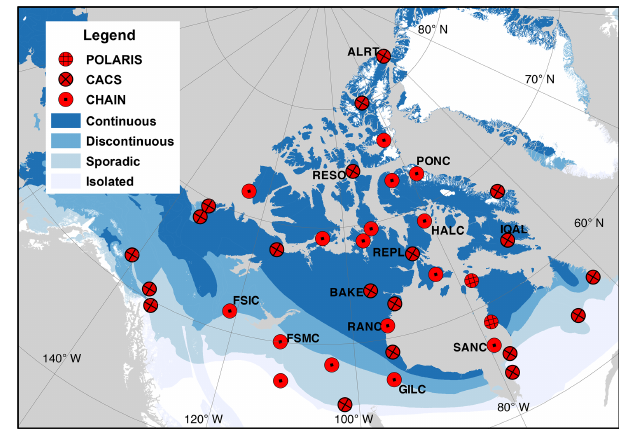
Figure 3. Locations of GPS stations in the Canadian permafrost areas. The identified stations are labeled by their four-character IDs.